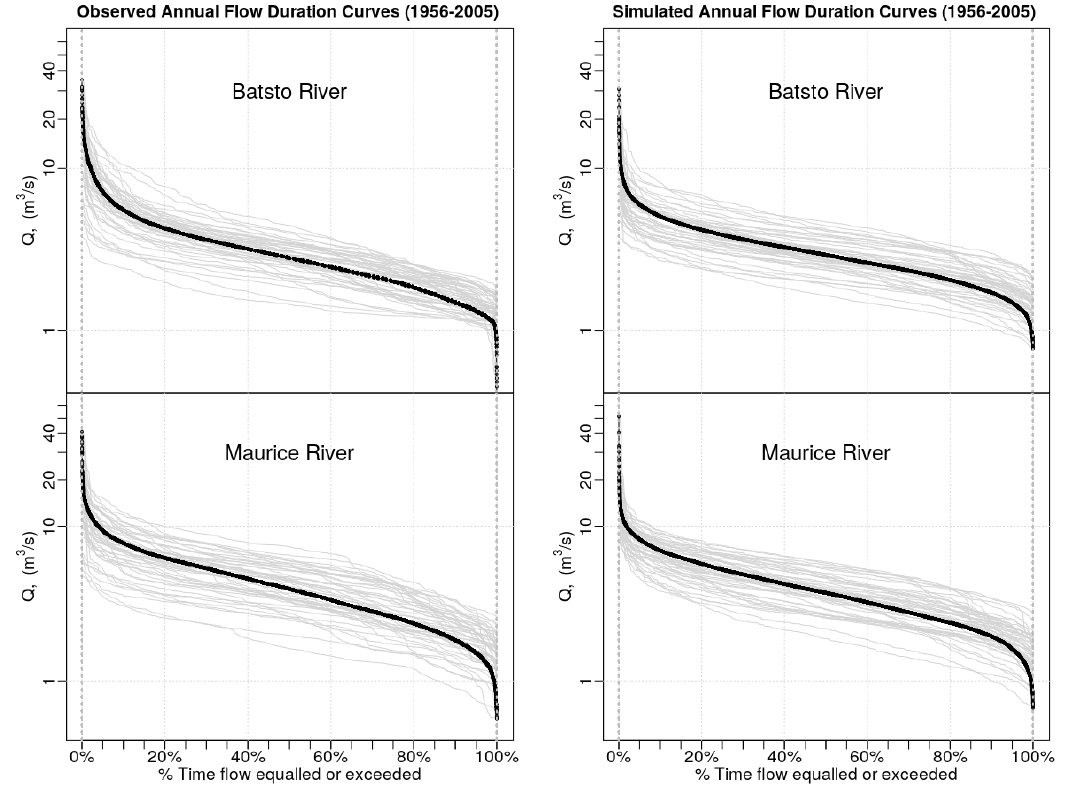
Figure 5. Observed (left) and PRMS simulated (right) annual flow duration curves for the Batsto and Maurice Rivers for water years 1956–2005. Thick black line represents the FDC for the full period of